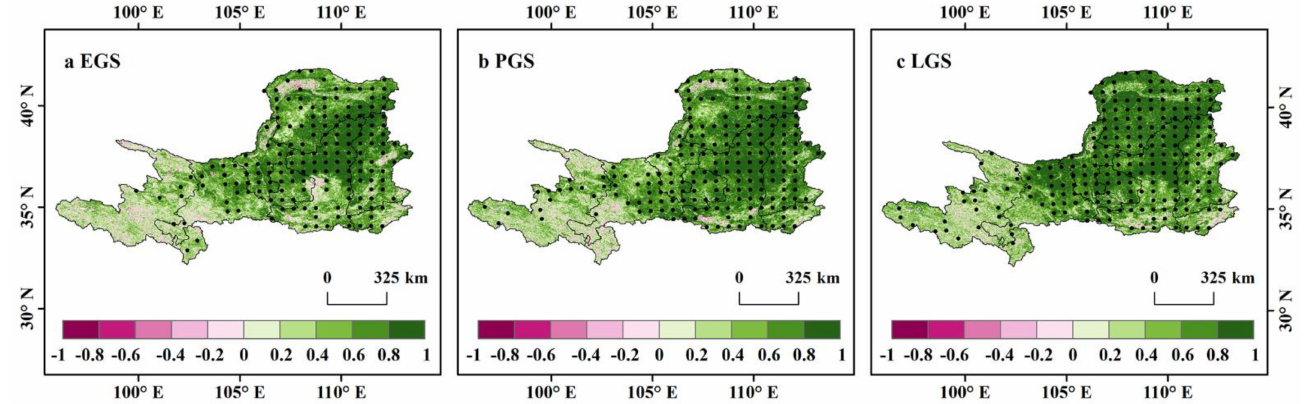
Figure 4. Spatial distribution of the partial correlations between NDVI of each season and that of the preceding season. Correlationpatterns are shown for EGS ( a ), PGS ( b ), and LGS ( c ). Compared with the positive effect of the VGC, the intensity and direction of climate factors, including the immediate and lagged impacts of climate, determining the inter- annual variation of seasonal NDVI (GPP and LAI) varied greatly between seasons and across regions (Figures 5, 6 and S6–S9). The concurrent precipitation is the primary climate factor determining the inter-annual variation of EGS and PGS NDVI of the upper and middle reaches of the YRB over the 20-year period (partial correlation: 0.3122, p < 0.05; 0.2686, p < 0.05, respectively) (Figures 3 and 5d–e). The positive impact of